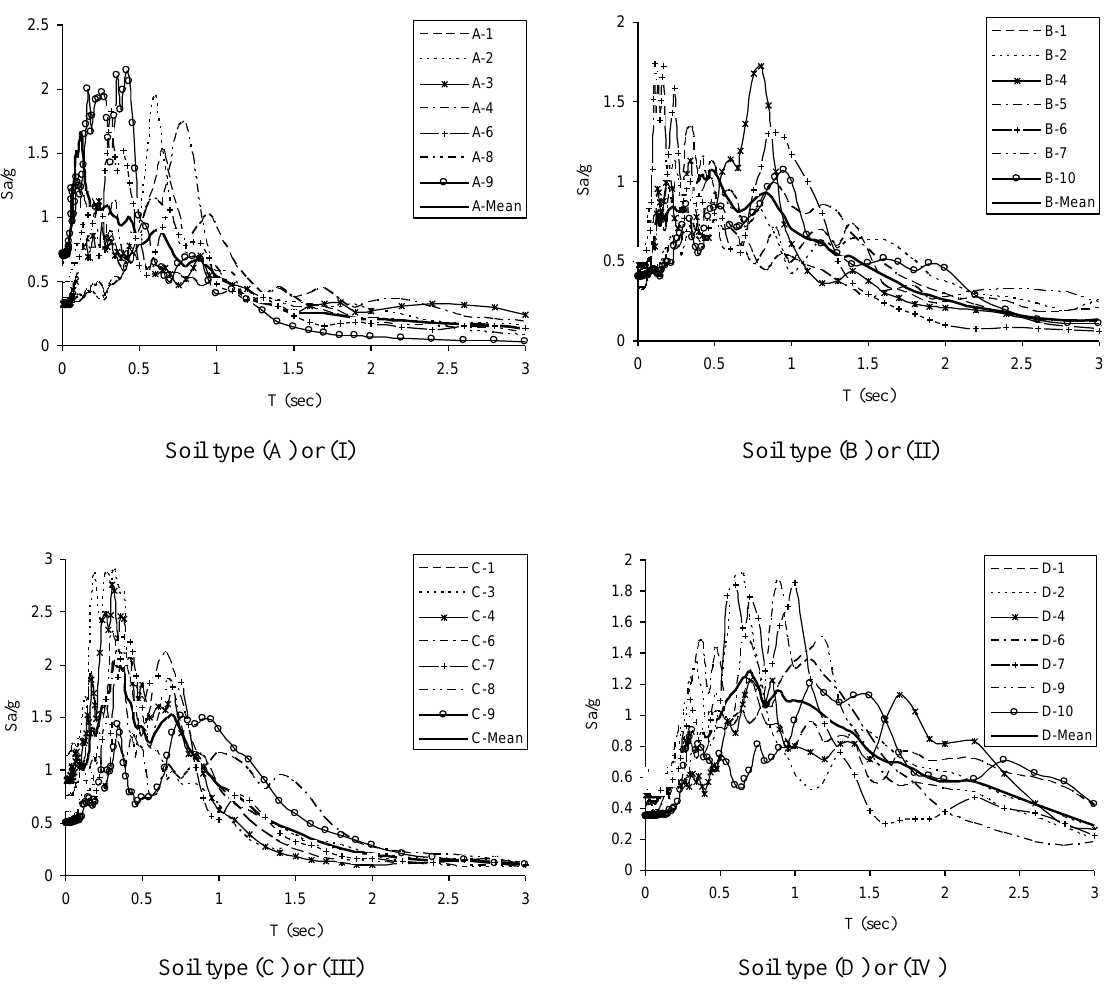
Fig. 14. Normalized acceleration response spectrums for different soils (  =5%).